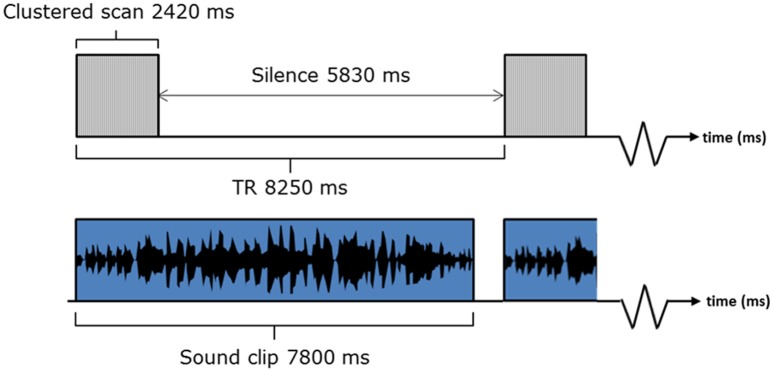
fMRI listening task paradigm.